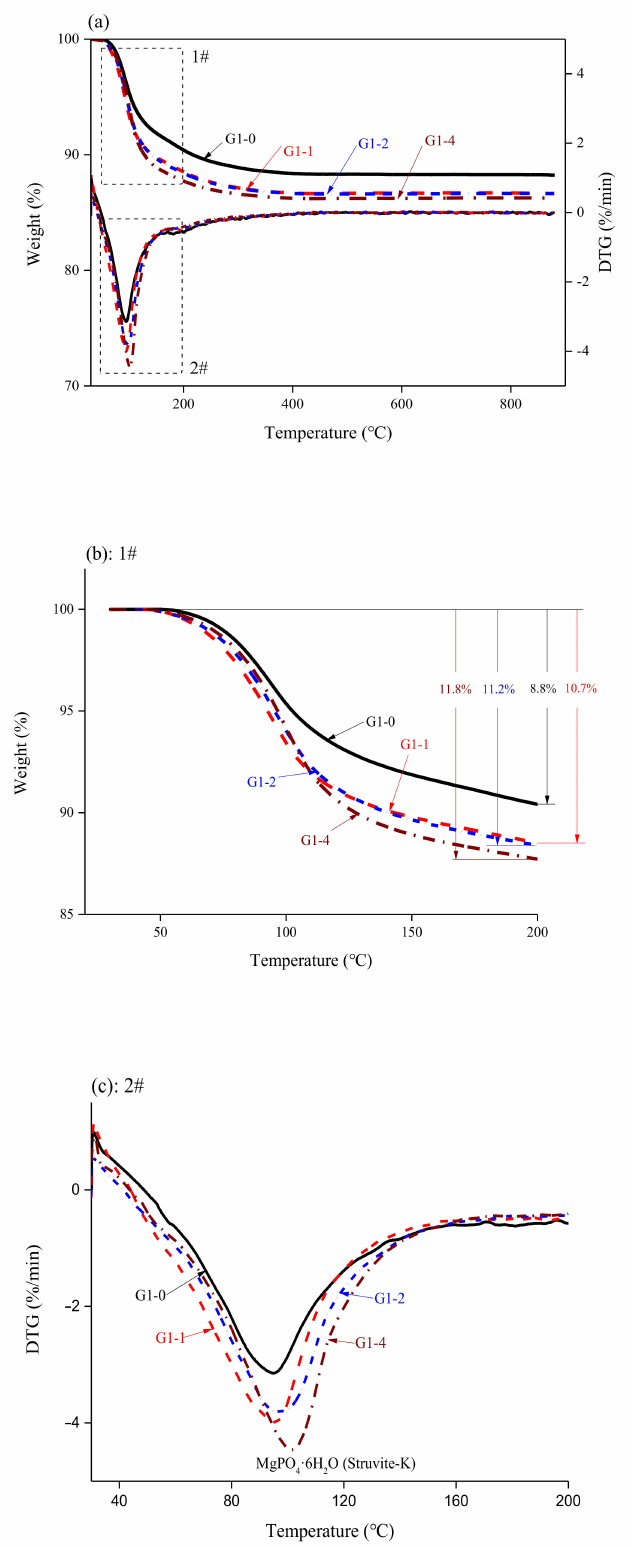
Figure 7. TG/DTG curves of the MKPC pastes with an M/P ratio of 1:1, containing 0 to 40 wt.% glass powder cured for 28 d, where ( a ) shows all curves and ( b ) and ( c ) are expanded graphs of areas 1 and 2 in ( a